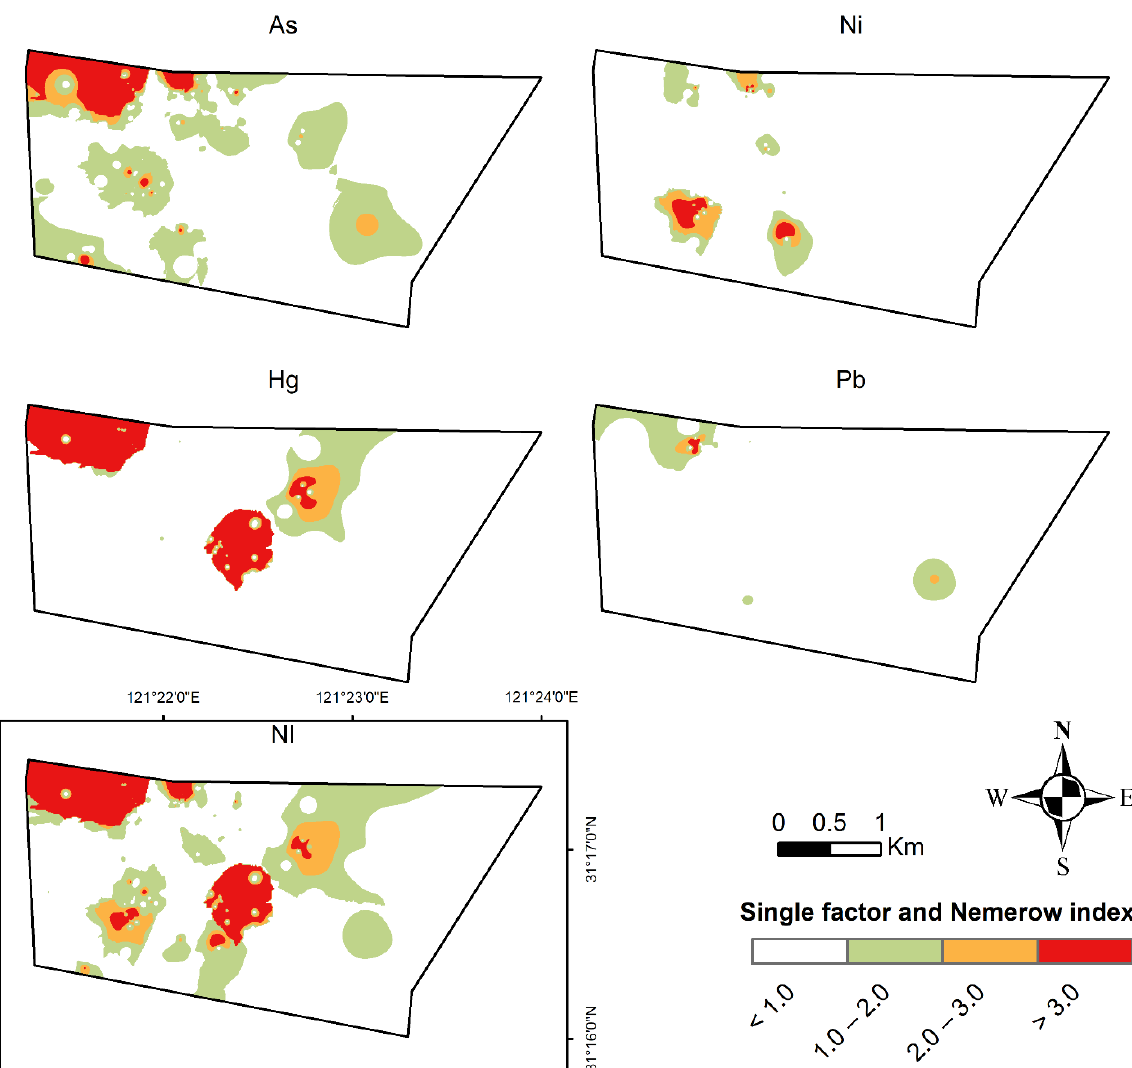
Figure 2. Classification map of heavy metal pollution by using single factor index and Nemerow index. (Elements without contamination were not displayed).